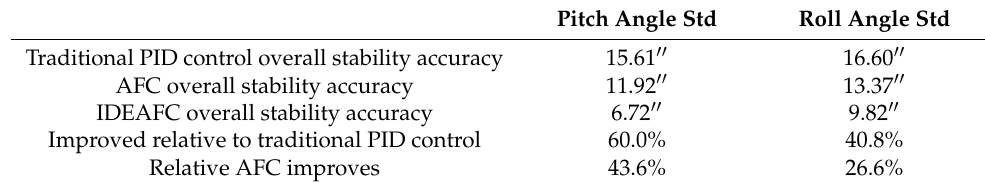
Table 5. Comparison of control e ff ects under dynamic rolling conditions.